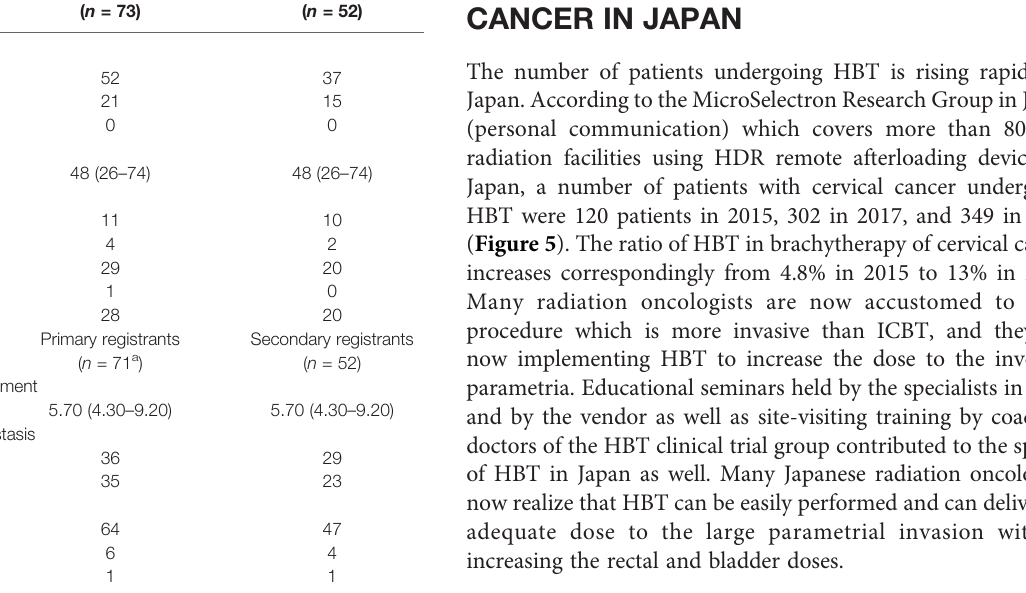
( Figure 5 ). The ratio of HBT in brachytherapy of cervical cancer increases correspondingly from 4.8% in 2015 to 13% in 2019.